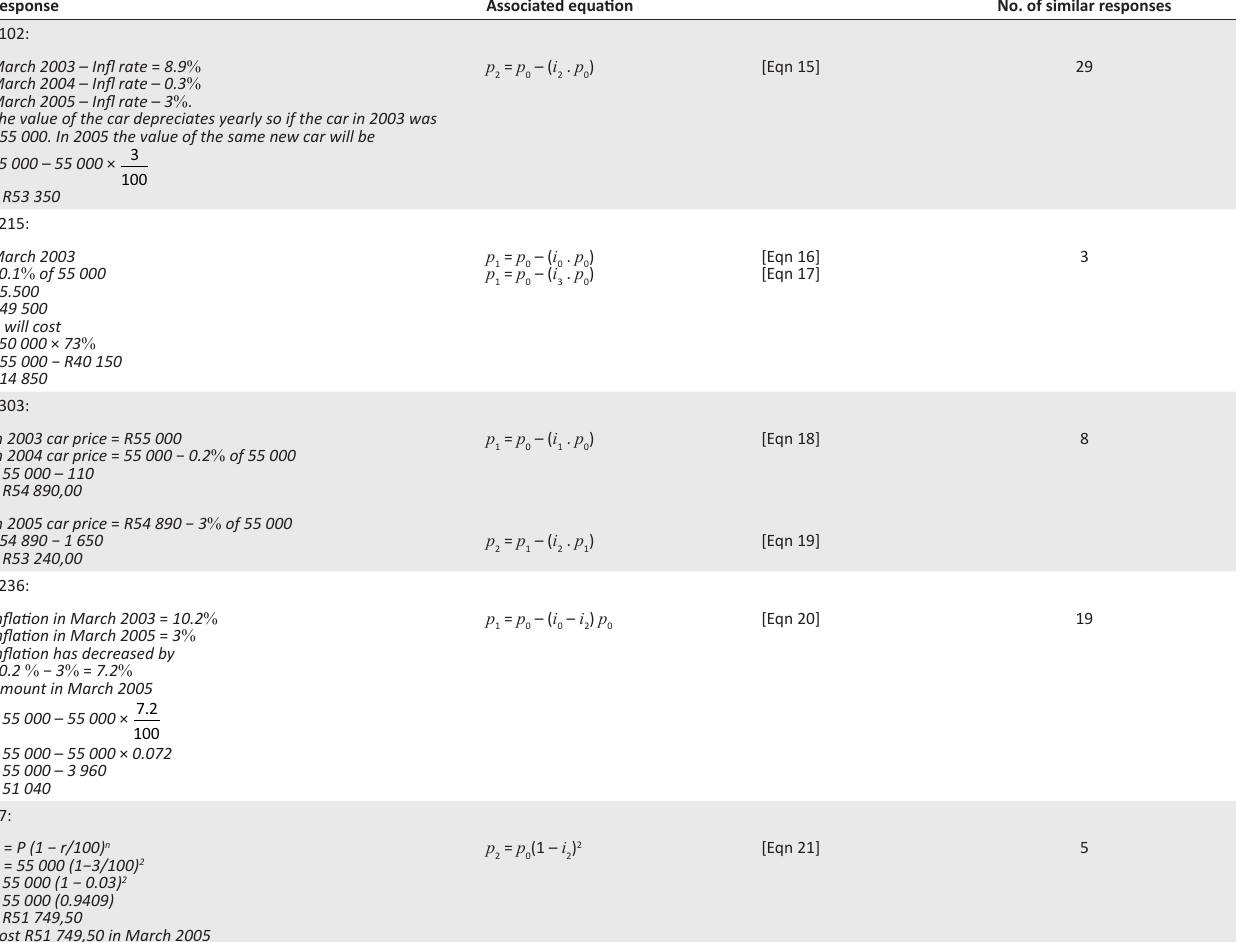
TABLE 6: Responses which assumed a decrease in price. Response